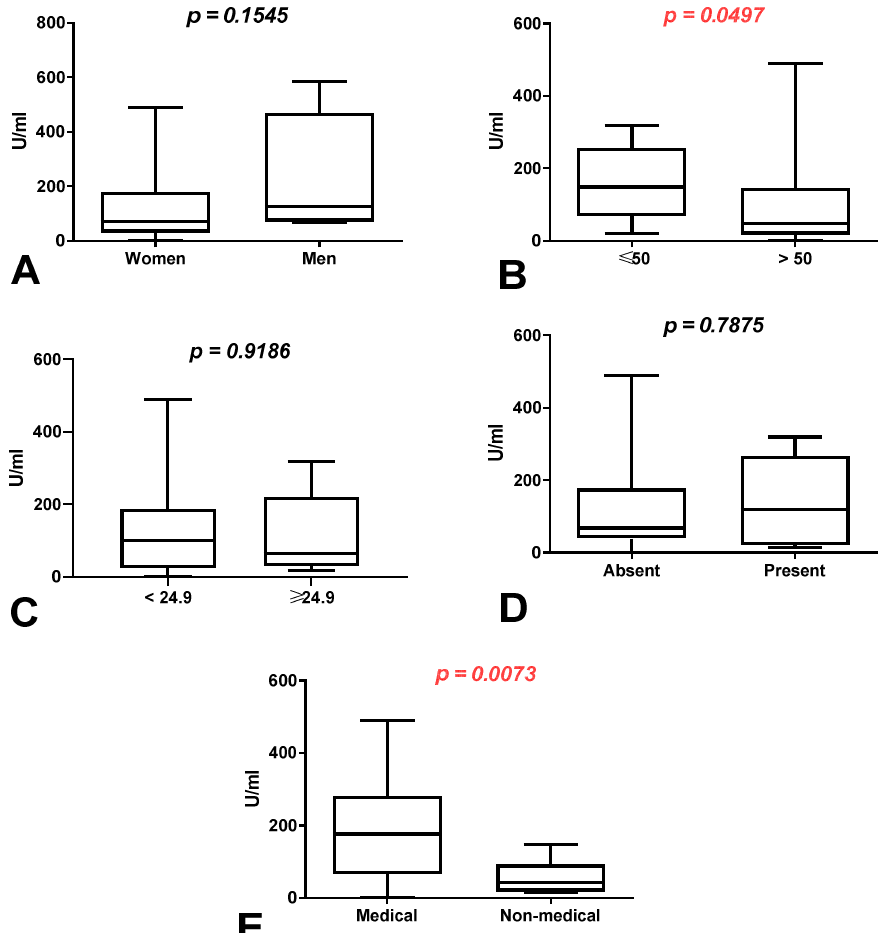
Figure 2. ( A ) Comparison of difference in total anti-SARS-CoV-2 antibody levels between first (after 8 months) and second determination (after 10 months) in the groups of women and men without a history of COVID-19. The data are presented as median (minimum–maximum). ( B ) Comparison of difference in total anti-SARS-CoV-2 antibody levels between first (after 8 months) and second